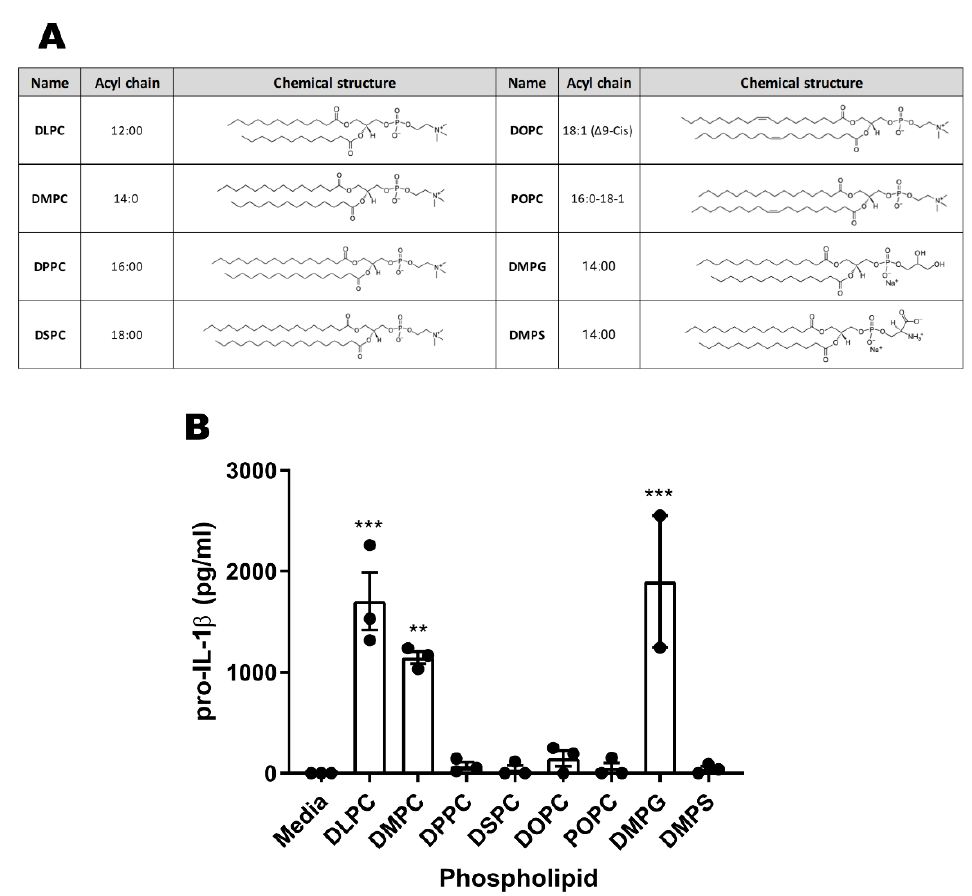
Figure 5. Both the acyl chain length and headgroup structure affect the activity of murine BMDCs. WT BMDCs were stimulated with a panel of phospholipids ( A ) as liposomes. ( B ) Stimulation of pro-IL-1 β production is dependent on lipid structure. After 5 h, lysates were collected and assayed for pro-IL-1 β by ELISA. Data are shown as the mean + / − SEM of n = 3 replicates. Data are representative of three experiments with similar results, showing mean ± SEM. Statistical significance was determined via one-way ANOVA followed by a Dunnett correction for multiple comparisons to the media-only group. ** p < 0.01 and *** p < 0.001.